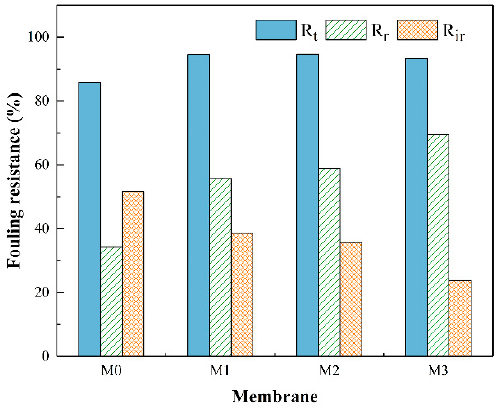
Figure 10. Water flux recovery ratio of the MXene / PSF membranes.